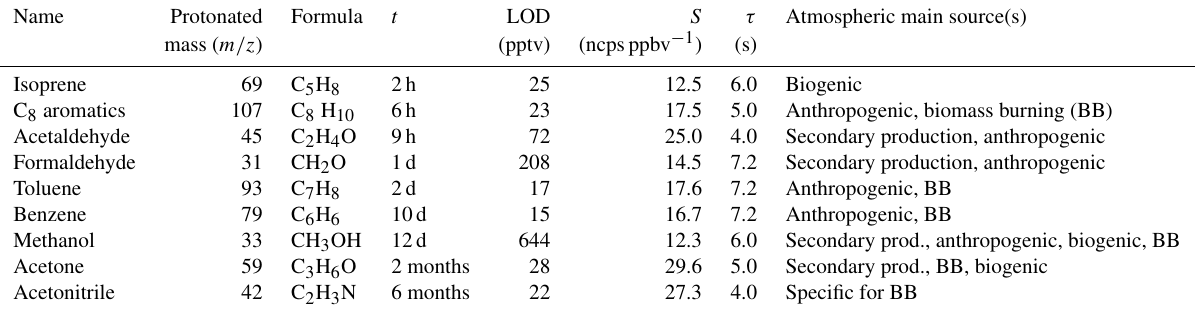
Figure 1. (a) Cumulative occurrences of HALO flight altitudes during EMeRGe and (b) last contact of probed air masses to planetary boundary layer (PBL) air, based on 10d FLEXTRA back trajectories and ERA5 meteorological data. Table 1. VOCs measured during EMeRGe-Europe and EMeRGe-Asia, with tropospheric lifetime t (as defined for a 12h daytime average OH radical concentration of 2 . 0 × 10 6 molec.cm − 3 ; Atkinson, 2000), lower limit of detection (LOD, for EMeRGe-Asia), maximal sensitivities S (ncps – normalised counts per second), mass spectrometric integrations times τ and the up to four main atmospheric